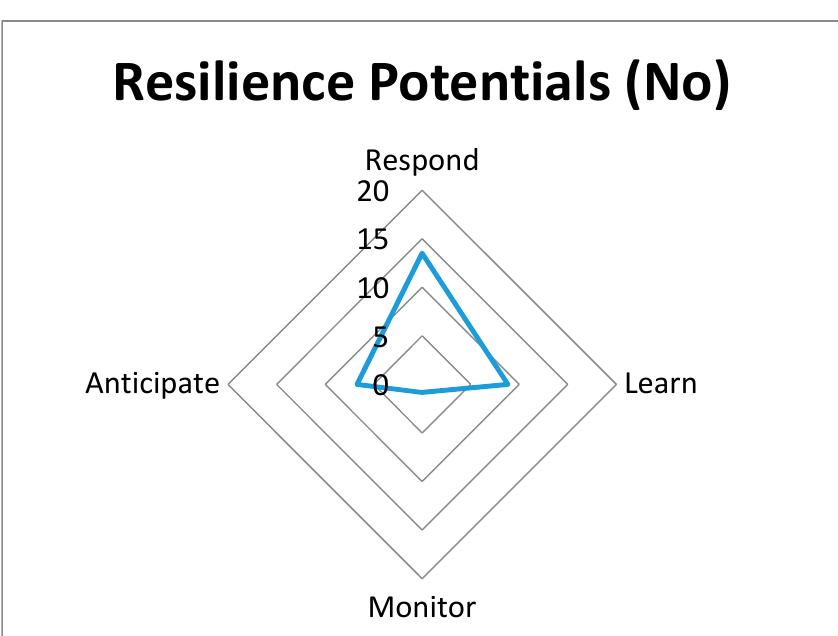
Figure 7. Four potentials as a percentage of No responses.